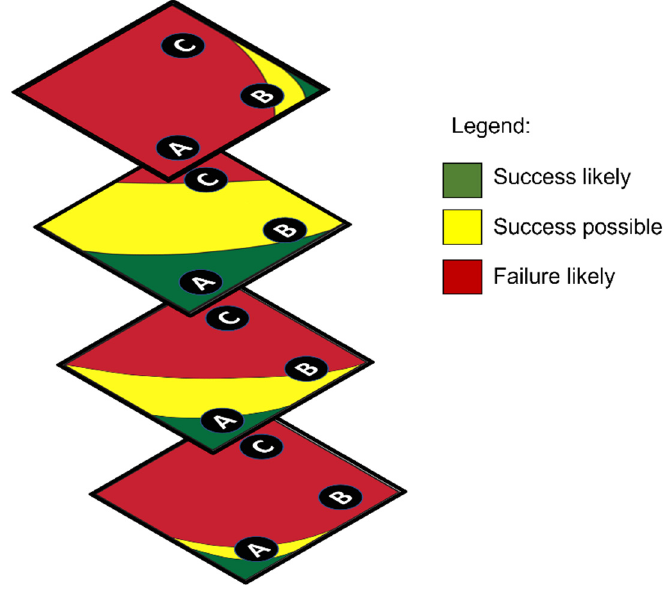
Figure 6. Likelihood of the Success of Three Alternative Strategies under Four Scenarios.